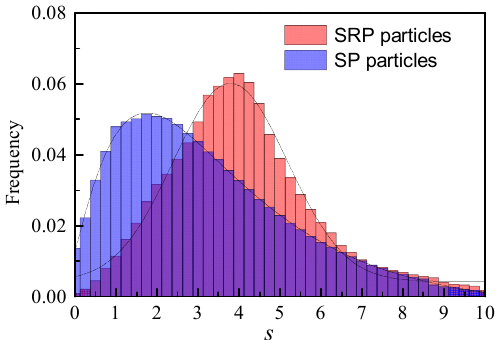
Figure 19. Frequency distributions of dimensionless angular velocity of sediment particles. Figure 20 presents the variation of particle angular velocity with the transport stage. It indicates that the angular velocity of the SP decreases with the increase of the transport stage; this trend is similar to the experimental results of Niño and García [9]. The difference may result from the particle shape and bed roughness. The shape of the particle affects the angular velocity of the particle, because a particle with an elongated shape colliding with the bed results in a higher angular velocity than a spherical shape [68]. Niño and García [9] pointed out that the particle angular velocity is controlled mainly by the process of collision with the bed. This phenomenon can be seen in Figure 7. The incidence angle and takeoff angle at collision also influence the particle angular velocity [8]. It also indicates that the angular velocity of the SRP increases with the increase of the transport stage. The greater the transport stage, the faster the rolling sediment particles move, and accordingly, the greater the angular velocity of the SRP. Figure 20. Comparison of angular velocity between the present model results and the experimental data with transport stage [9]. 5. Conclusions In this study, the motion trajectories, the dynamic responses, the corresponding hy- drodynamic forces, and the statistical characteristics of sediment particle movement (slid- ing, rolling, and saltation) are studied through simulating the movement of sediment par- ticles using a coupled CFD-FDEM model. The conclusions are summarized as follows: The bed load sediment particles have a different motion trajectory under the fluctu- ating velocity of turbulent flow. The inter-particle collision between moving sediment par- ticles has an important effect on the characteristics of moving sediment particles. The in- ter-particle collision in the low concentration increases the saltation length, height, and Experiment (Niño and Garcia, 1998) Present simulation (SRP) Present simulation (SP) S